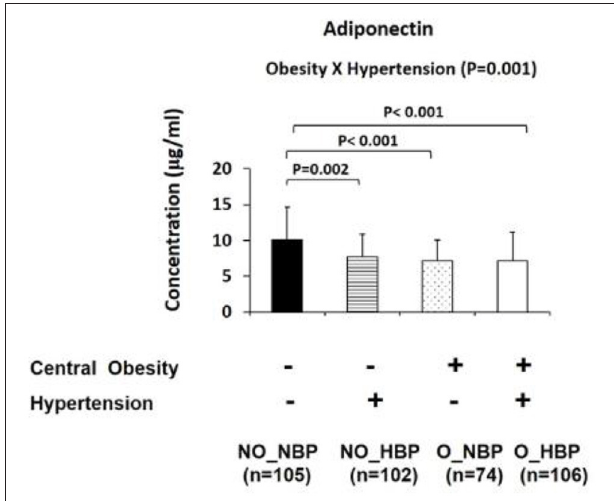
FIGURE 2 | Bar graphs represent circulatory abundance of anti-inflammatory adipokine adiponectin in Hong Kong Chinese women categorized into four groups, including (1) Non-central obese subjects with normal blood pressure (NO_NBP; n = 105), (2) Non-central obese subjects with hypertension (NO_HBP; n = 102), (3) Central obese subjects with normal blood pressure (O_NBP; n = 74), and (4) Central obese subjects with hypertension (O_HBP; n = 106). Subjects with hypertension were defined as having systolic blood pressure ≥ 140 mmHg and diastolic blood pressure ≥ 90 mmHg, and subjects with central obesity were defined as having a waist circumference ≥ 80cm. The data are expressed as the mean ± standard